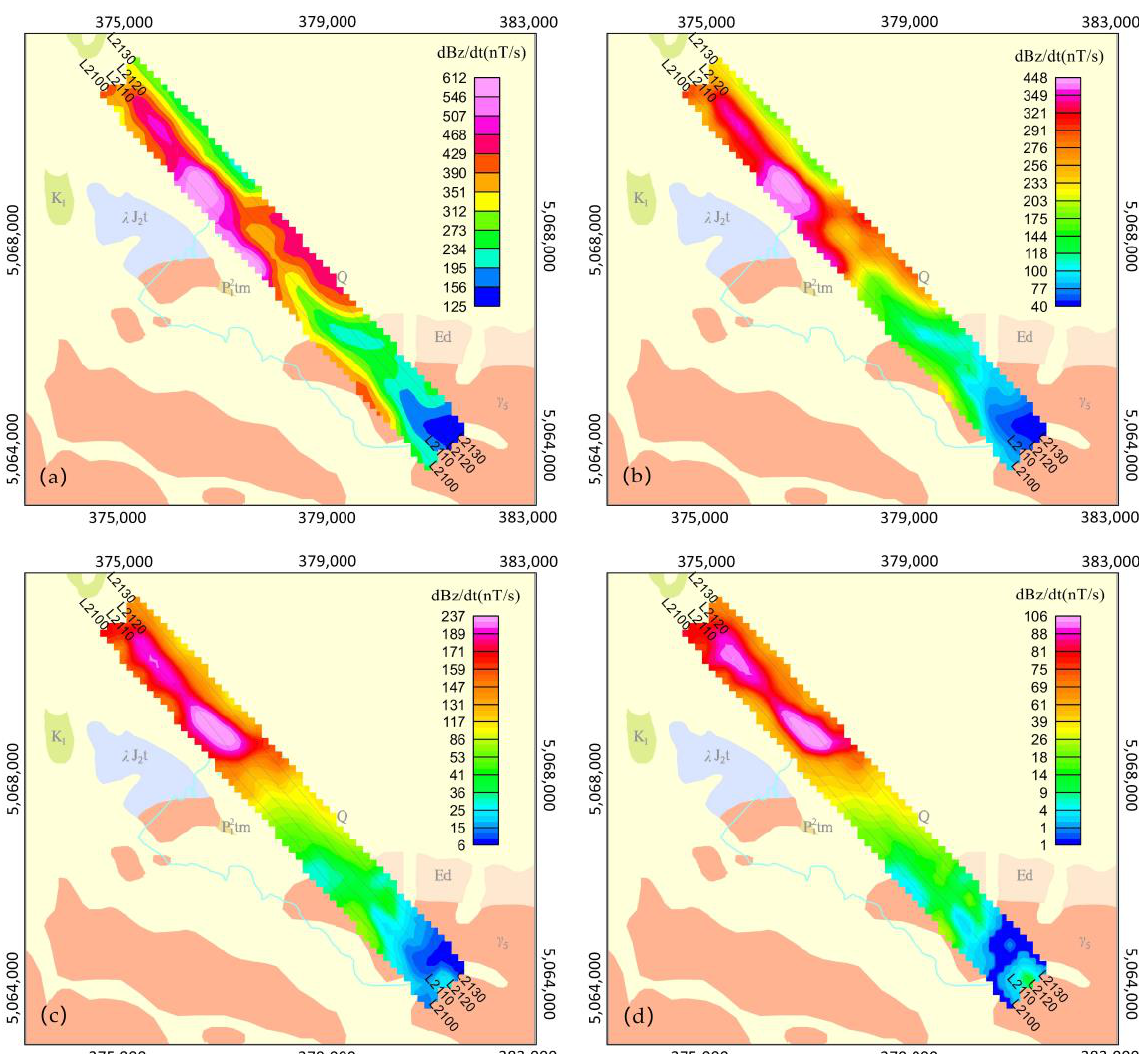
Figure 8. Contour map of dBz/dt of 4 different sampling channels. ( a ) CH1; ( b ) CH5; ( c ) CH10; ( d ) CH15.